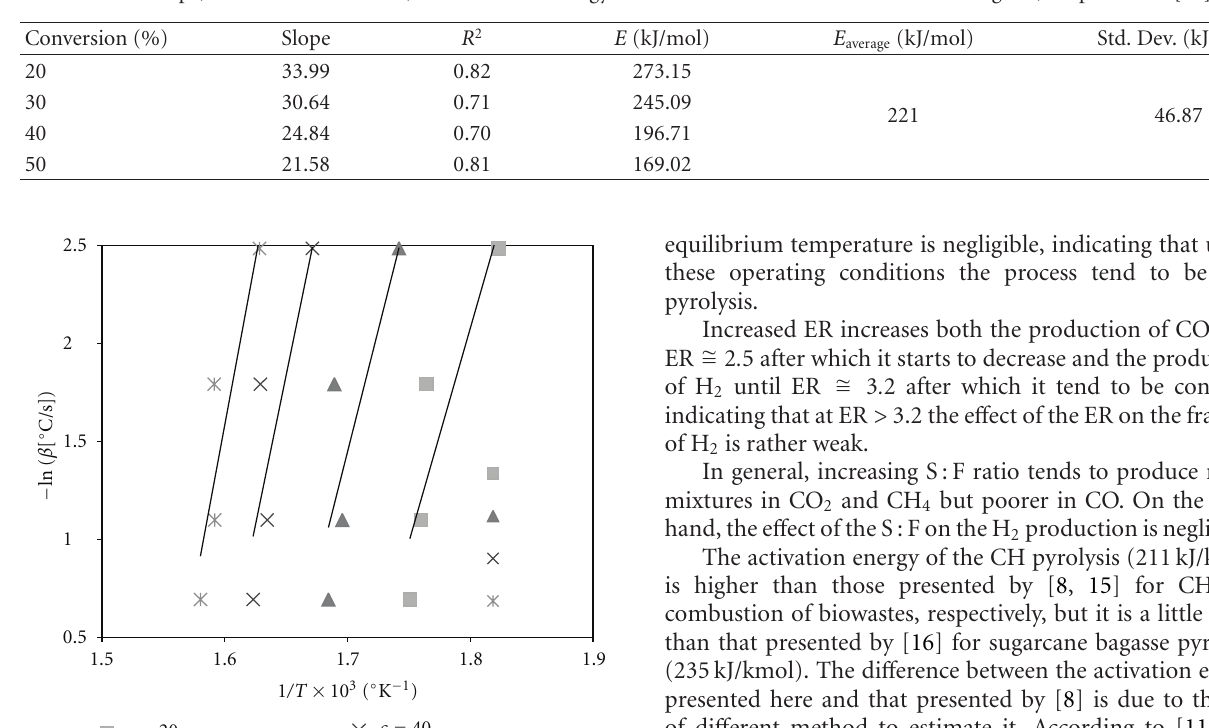
Table 8: Slope, correlation coe ffi cient, and activation energy obtained from 9 for various conversion degrees, adapted from [14].